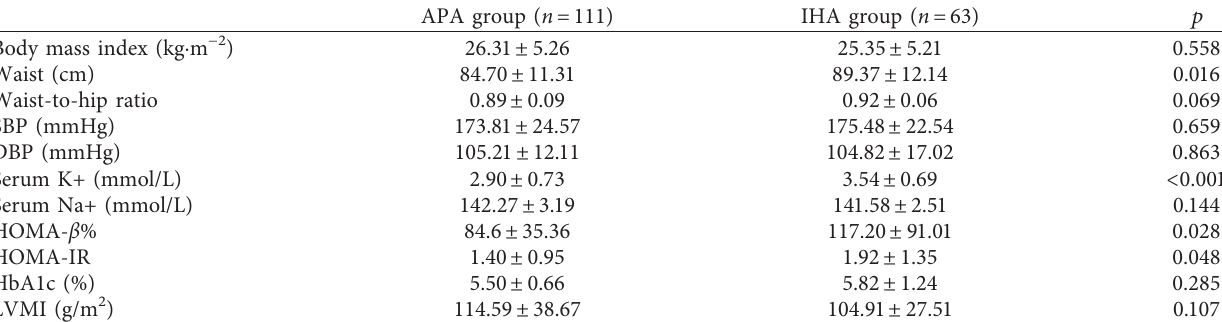
Figure 1: The blood glucose and insulin of OGTT of the three indicated groups. Group A represents patients with primary al- dosteronism (PA); Group B represents patients with essential hypertension (EH); Group C represents patients with nonfunctioning adenomas. (a) The curves of the OGTT (0 min, 30 min, 120 min) blood glucose of the indicated group of patients. (b) The AUC of glucose in patients with PA and EH was greater than that in the patients with nonfunctional adenoma. (c) The curves of the si- multaneous insulin secretion of the indicated groups of patients. (d) The AUC of insulin in the EH group was significantly higher than that in the other two groups. ∗ P < 0.05; # P < 0 . 05 EH group compared to nonfunctioning adenomas group; & P < 0 . 05 PA group compared to nonfunctioning adenomas group; $ P < 0 . 05 EH group compared to PA group. Table 3: Comparison of clinic features between APA and IHA